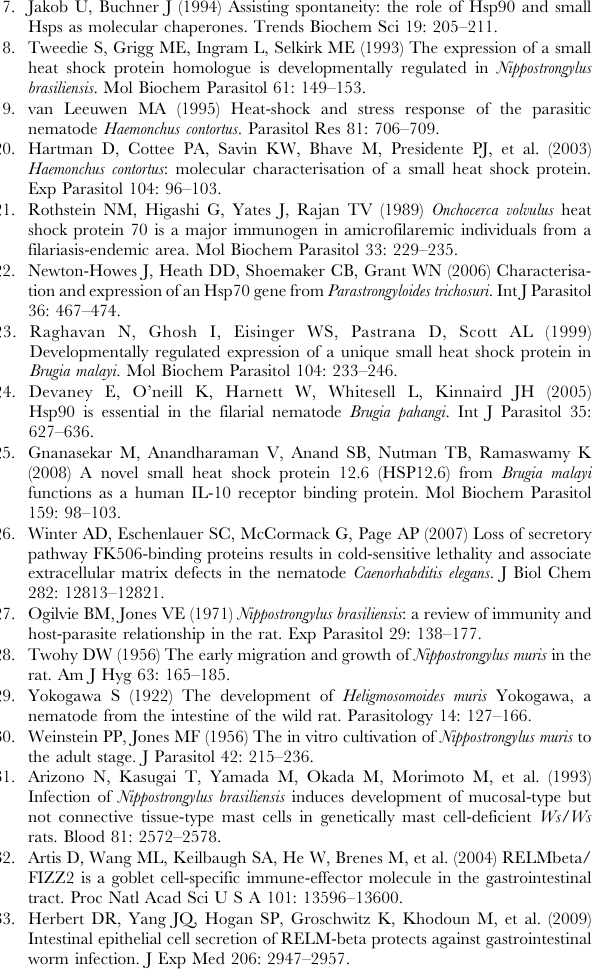
Figure S5 Structural superpositions of N. brasiliensis HSP12.6 and C. elegans HSP12.6 (A) and N. brasiliensis FKB-3 and C. elegans FKB-3 (B). RMSD, the distance between the backbones of superimposed proteins. Total RMSD, the average RMSD for all molecules. The position of motifs analyzed by Prosite is indicated by bars. 1 Hsp20 family, which includes a variety of small Hsps. 2 (TIF) Figure S6 Hsp-gene expression levels of N. brasiliensis recovered from rnu/rnu rats (open columns) and rnu / + rats (closed columns). At 21 days PI, as all worms had been expelled from rnu / + rats, only data from rnu/rnu rats are shown. Gene expression levels are normalized to those of Nb -globin b. The levels in worms recovered from rnu / + rats at 7 days PI are expressed as 1.0.